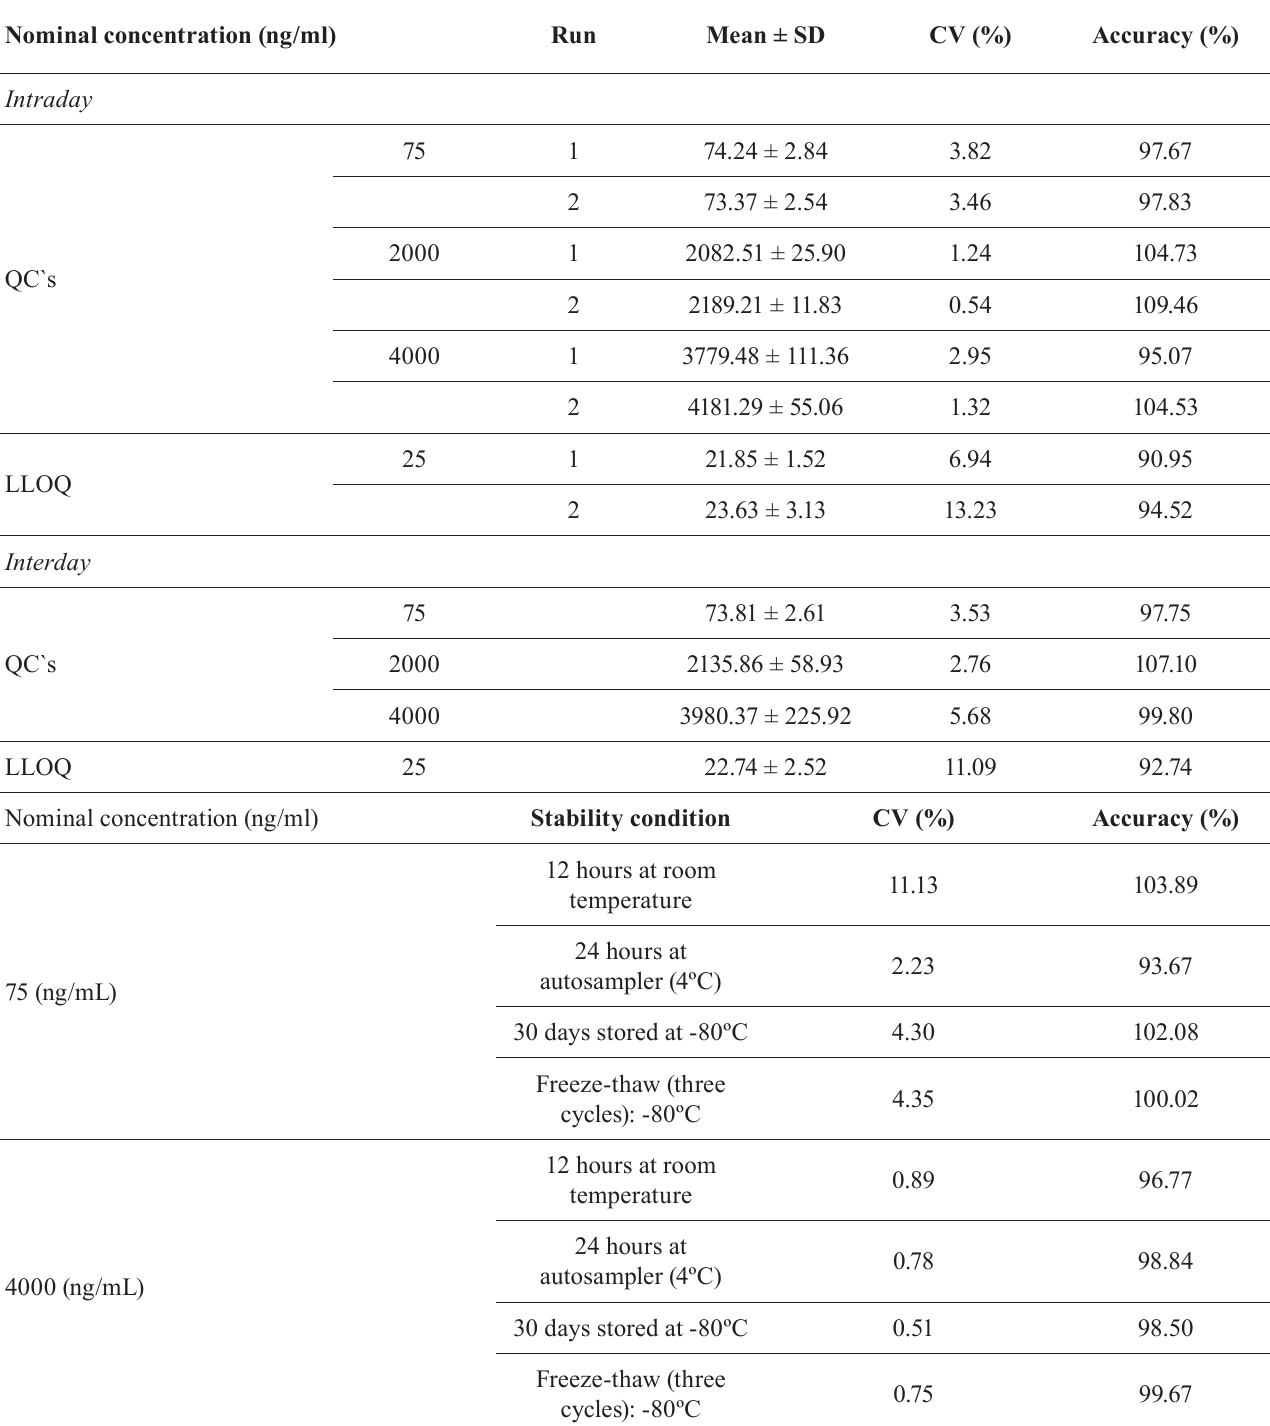
TABLE I - A ccuracy and precision on intraday and interday runs and stability of metformin in Ringer’s solution